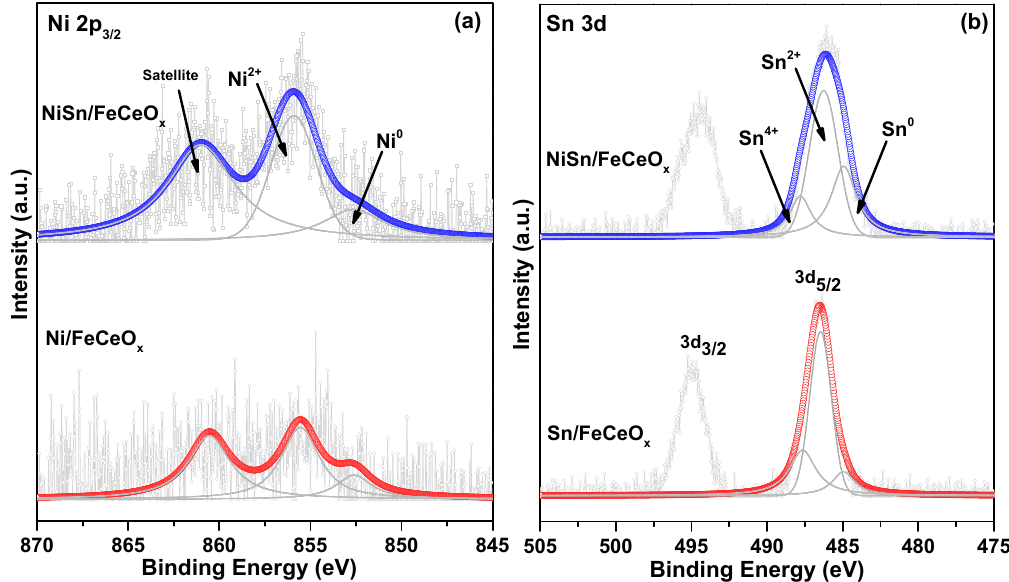
Figure 7. ( a ) Ni 2p and ( b ) Sn 3d XPS spectra of reduced Ni/FeCeO x and Sn/FeCeO x catalysts,